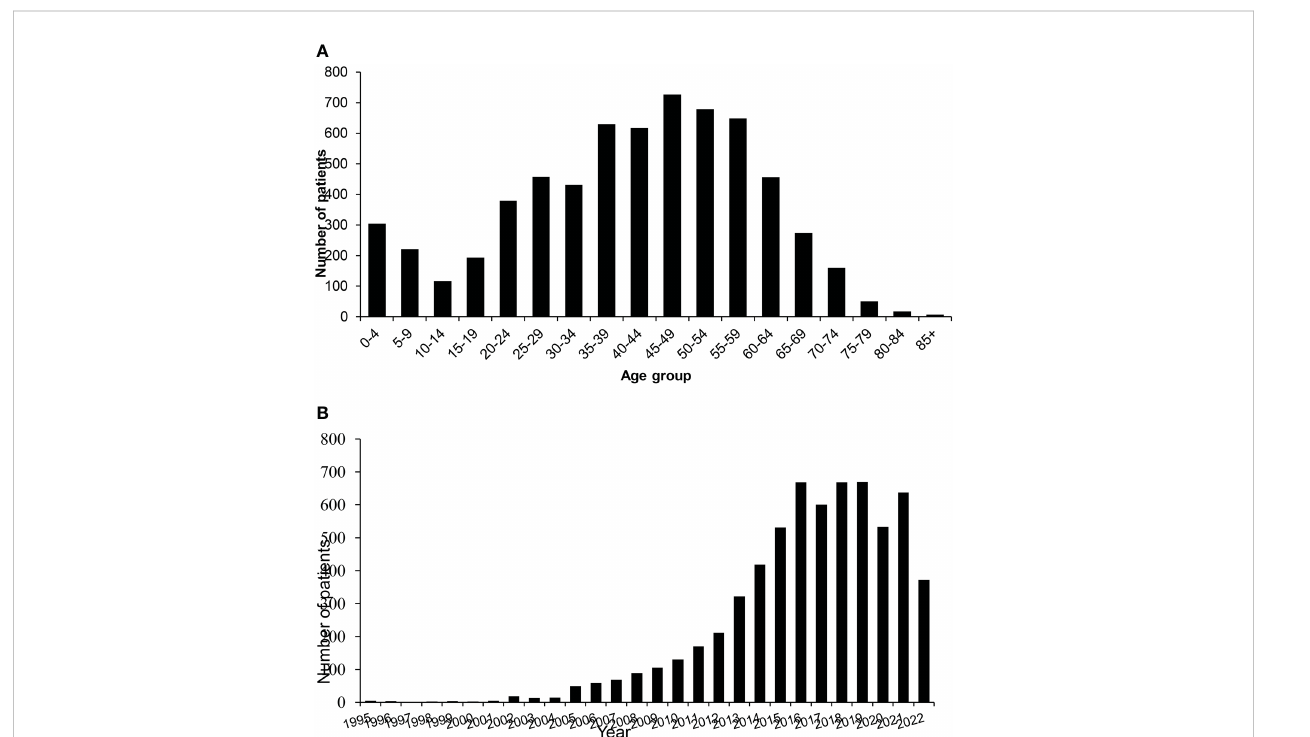
FIGURE 1 Afghan migrants treated at SKMCH&RC (n = 6,370) from 1995 to 30 th June 2022. (A) Age distribution. (B) Frequency of Afghan patients by